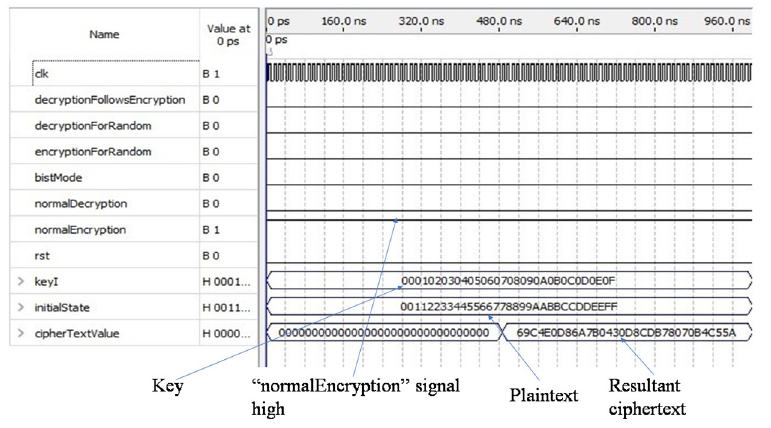
Fig 5. Simulation result of encryption module in normal mode.